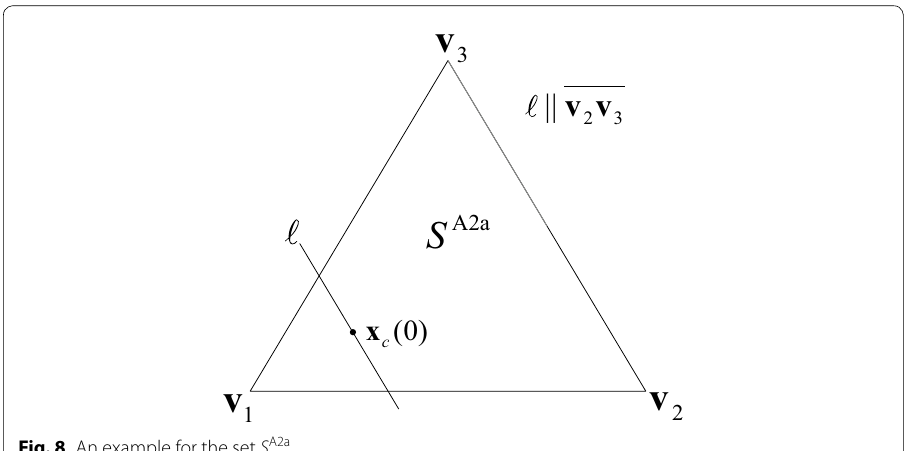
Fig. 8 An example for the set S A2a